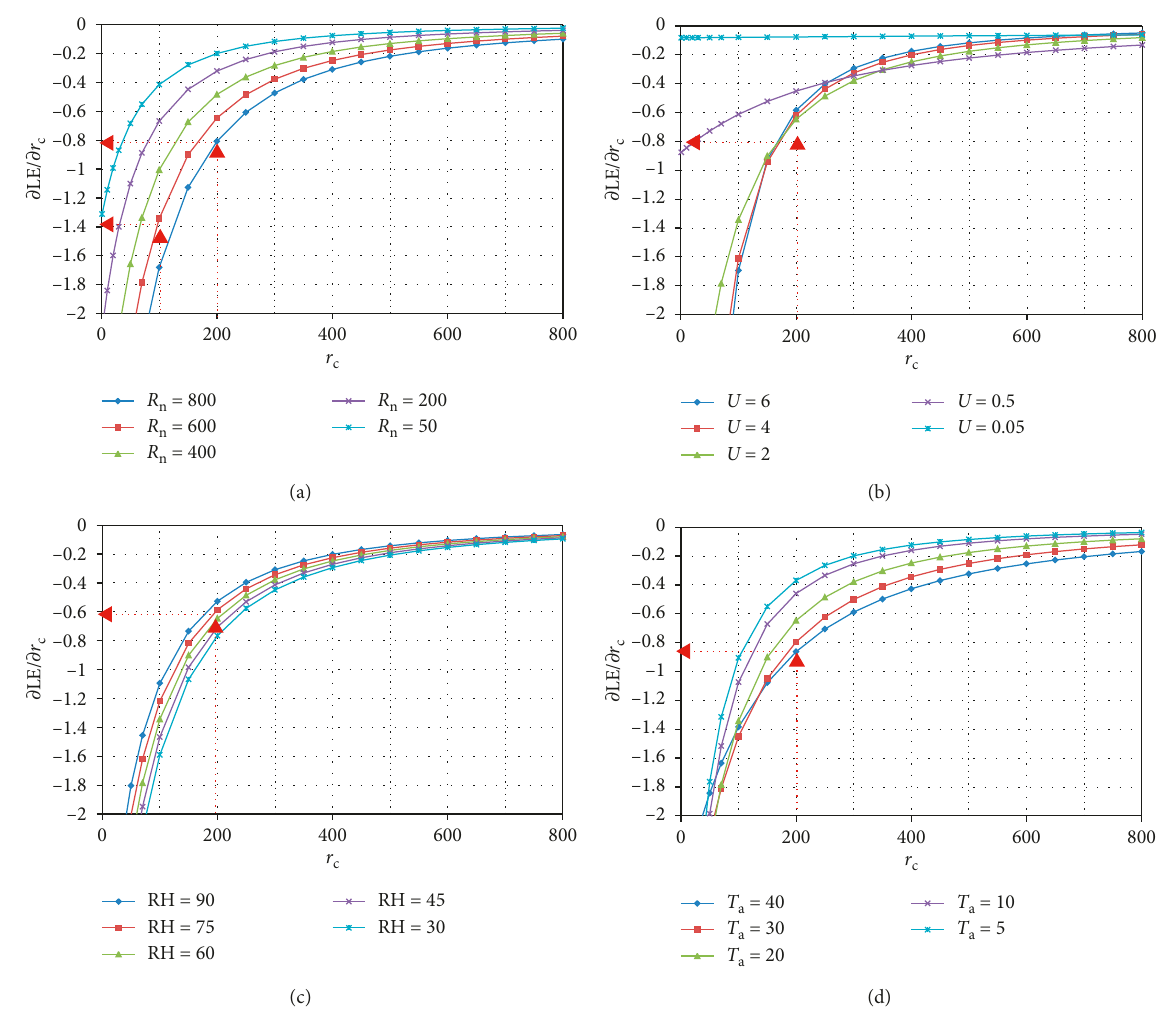
° C), RH 60%; (b) R n 600 (cid:29) (cid:29) 600 (W m − 2 ), U 2 (m/s), RH 60%. (cid:29) · (cid:29) (cid:29)